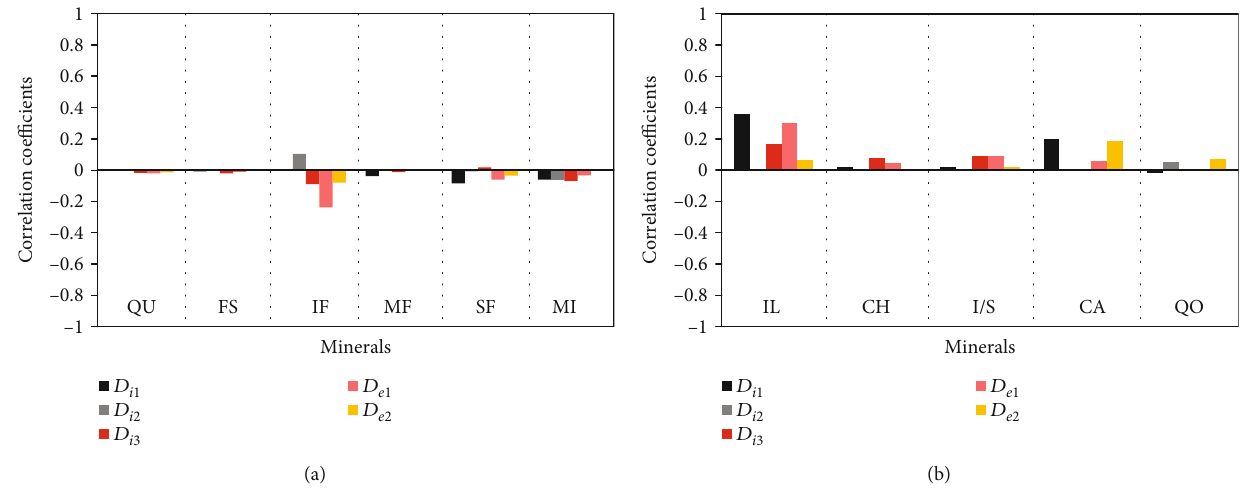
Figure 7: Correlation coe ffi cients of the (a) skeleton particles and (b) interstitial minerals and fractal dimensions. Positive values mean positive relationships, while negative values represent a negative correlation. QU: quartz; FS: feldspar; IF: igneous rock fragments; MF: metamorphic rock fragments; SF: sedimentary rock fragments; MI: mica; IL: illite; CH: chlorite; I/S: I/S mixed layer; CA: carbonate; QO: quartz